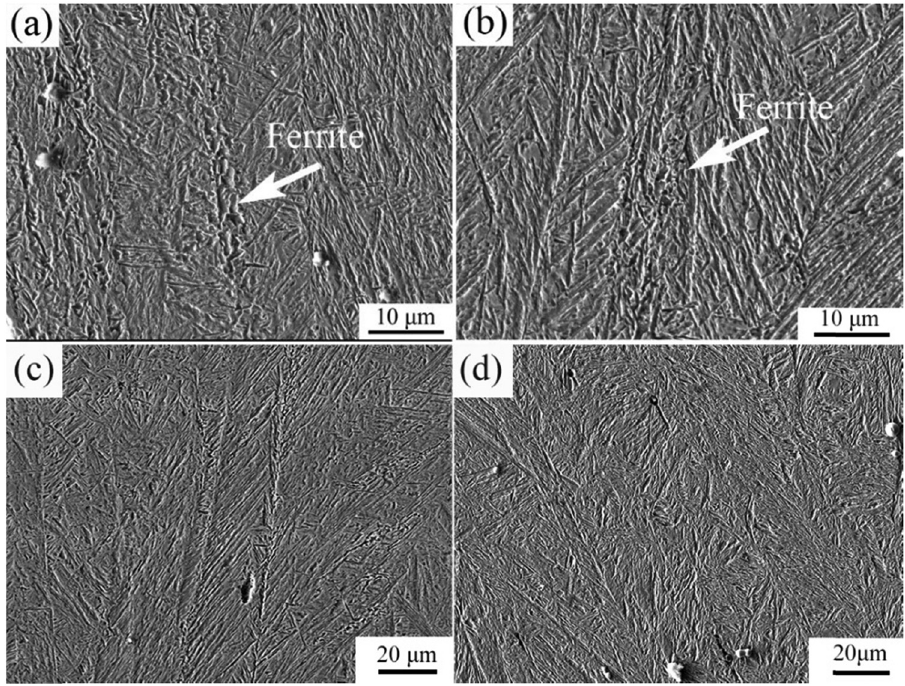
Figure 8: Microstructure near fracture surface strained at 750°C with a strain rate of 0.5 s − 1 observed by FE - SEM: ( a ) steel 1#; ( b ) steel 2#; ( c ) steel 3#; ( d ) steel